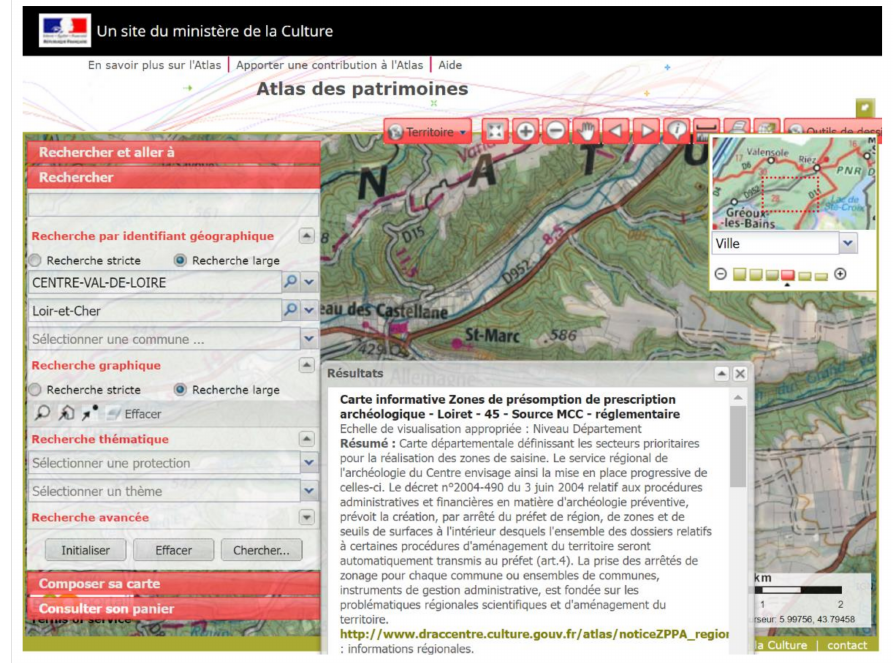
Figure 2. France Atlas des patrimoines: the search result for historical monuments in “Centre Val de Loire” geographical